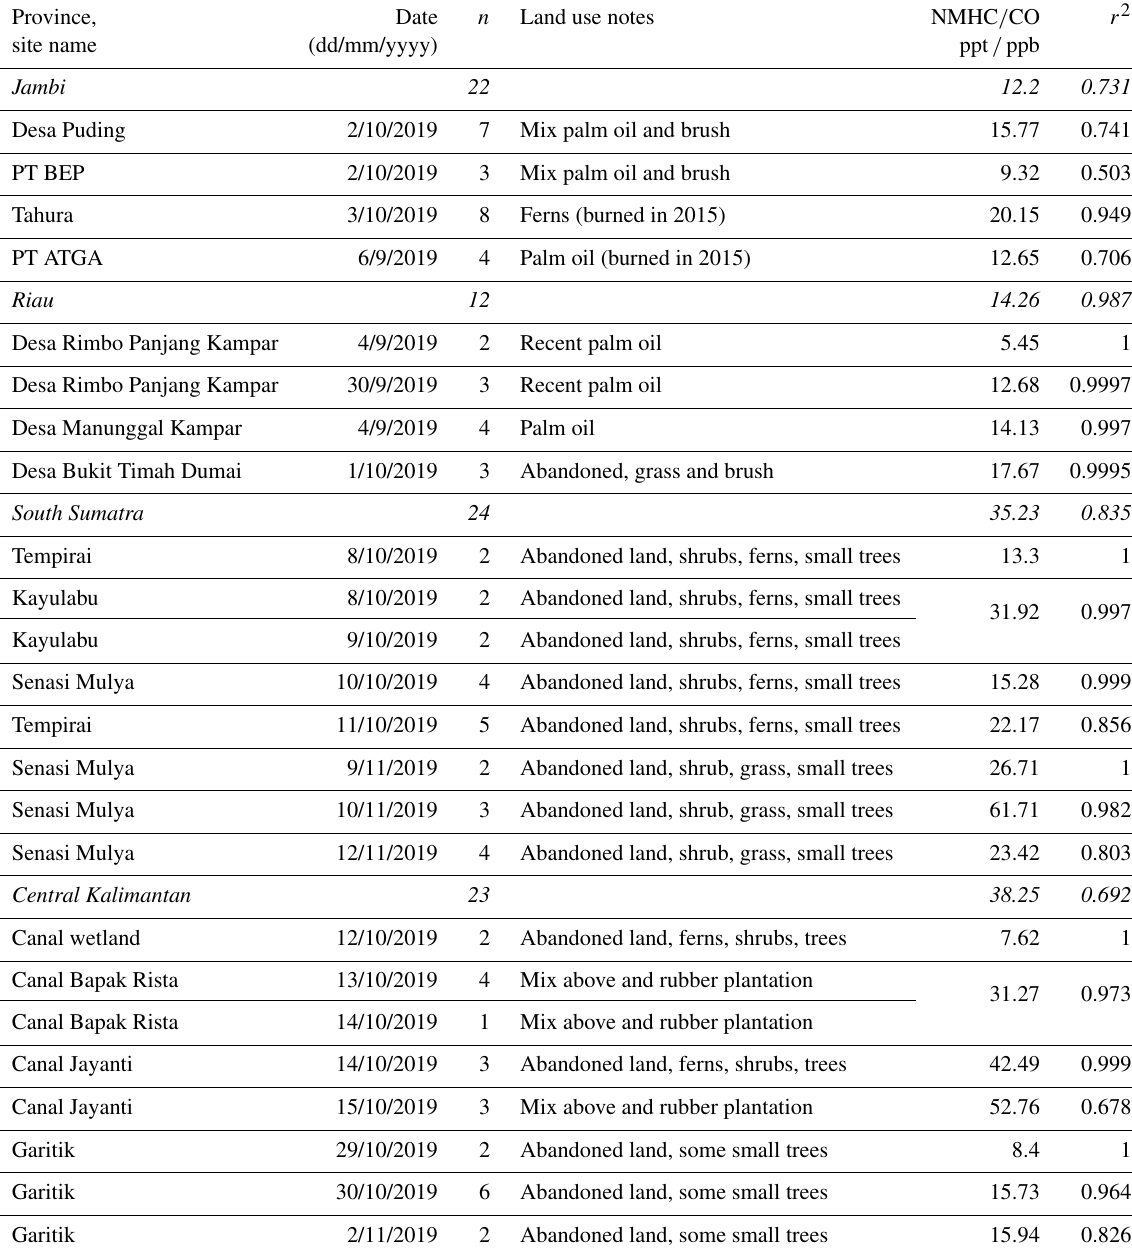
Table 1. Summary of sites and plumes sampled in 2019. The (cid:49) NMHC /(cid:49) CO ratio is shown for each plume and also (in italics) based on a plot including all the samples in a